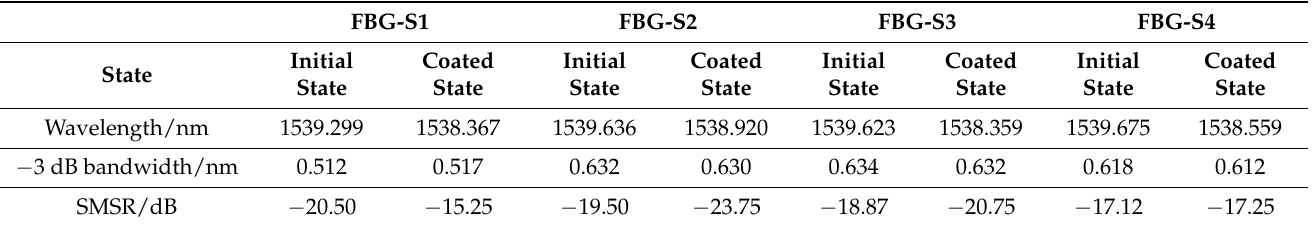
Table 1. Optical parameter comparison of the FBG strain sensors in the initial state and after UV irradiation and heating. The test temperature was 25.0 ◦